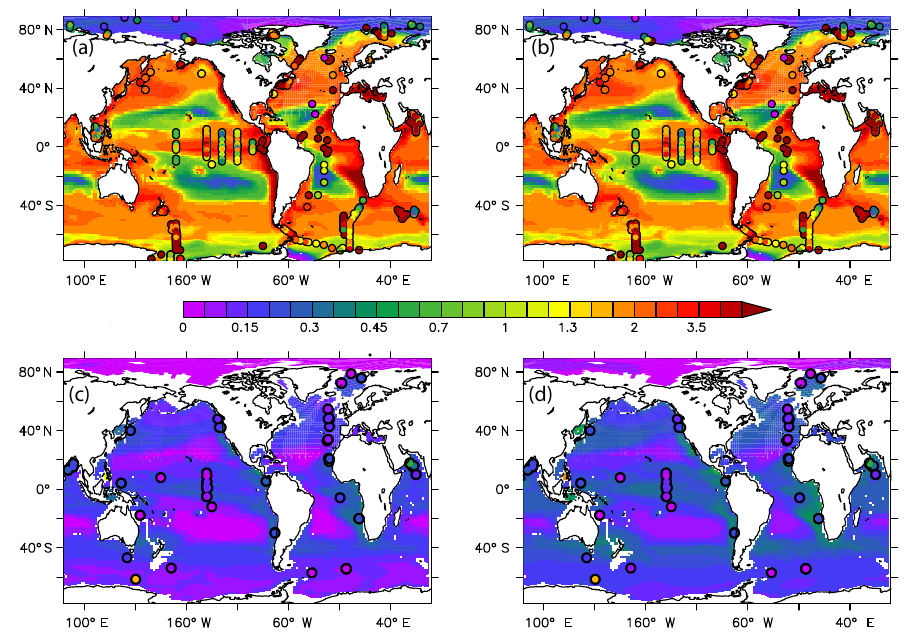
Figure 6. Sequestration of POC. The panels on the left show POC fluxes for the simulation without the lability parameterisation; i.e. sPOC and bPOC have a single lability ( noRC ). Those on the right are with the lability parameterisation ( RC ). The upper two panels (a, b) show the modelled flux at 100m; the observations are from the same depth ± 20m. Panels (c, d) show the flux through 2000m; the observations are at the same depth ± 400m. The datasets used in these figures are from Dunne et al. (2005), Gehlen et al. (2006), and Le Moigne (2013). Fluxes are in molm − 2 year − 1